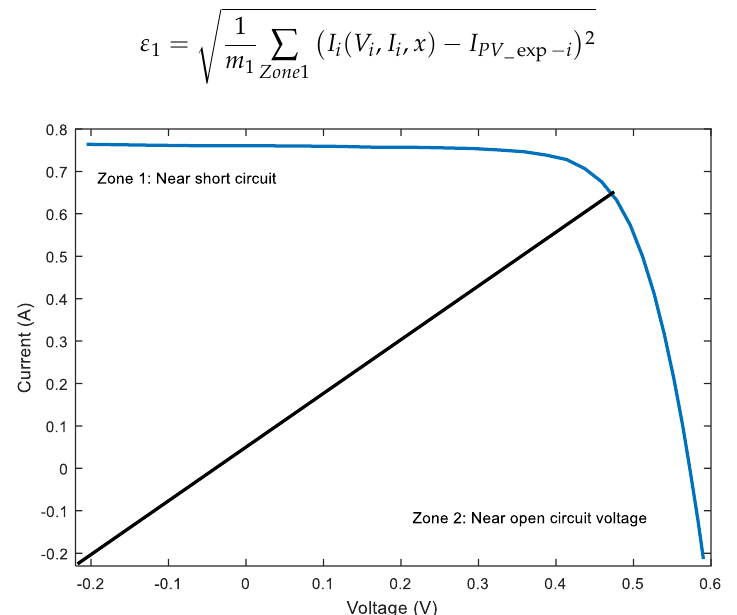
Figure 2. The characteristic current-voltage division in two zones.